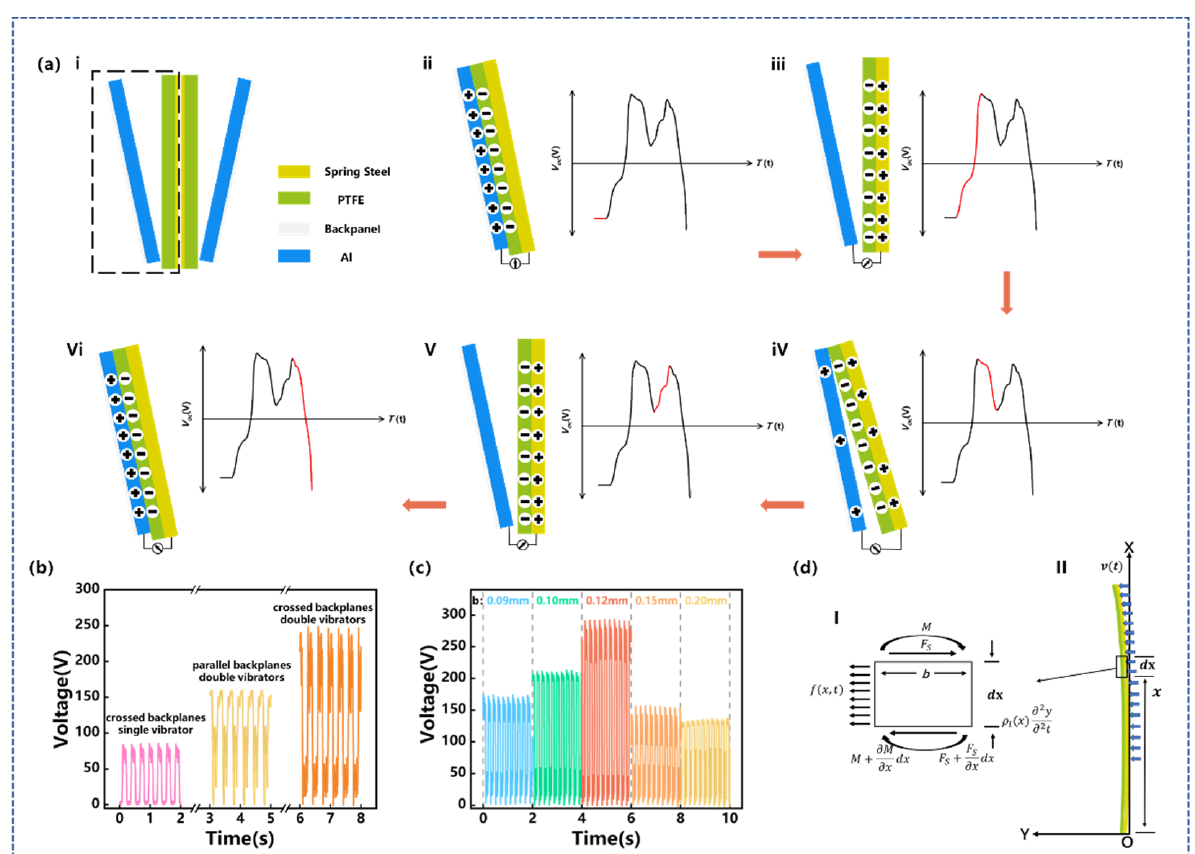
Figure 3. ( a ) Working principle of CB-TENG; ( b ) diagram of CB-TENG voltage output under different backplane structures and different number of vibrators; ( c ) diagram of CB-TENG voltage output at f = 3.0 Hz, A = 50 mm with different thickness of spring steel; ( dI ) force analysis diagram of unit length vibrator section; ( dII ) schematic diagram of single vibrator overall force.